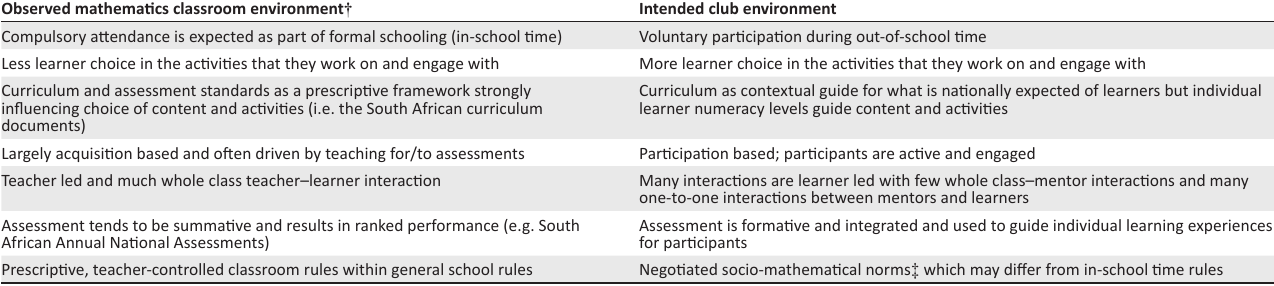
TABLE 1: Contrasted classroom and club environments. Observed mathematics classroom environment † Intended club